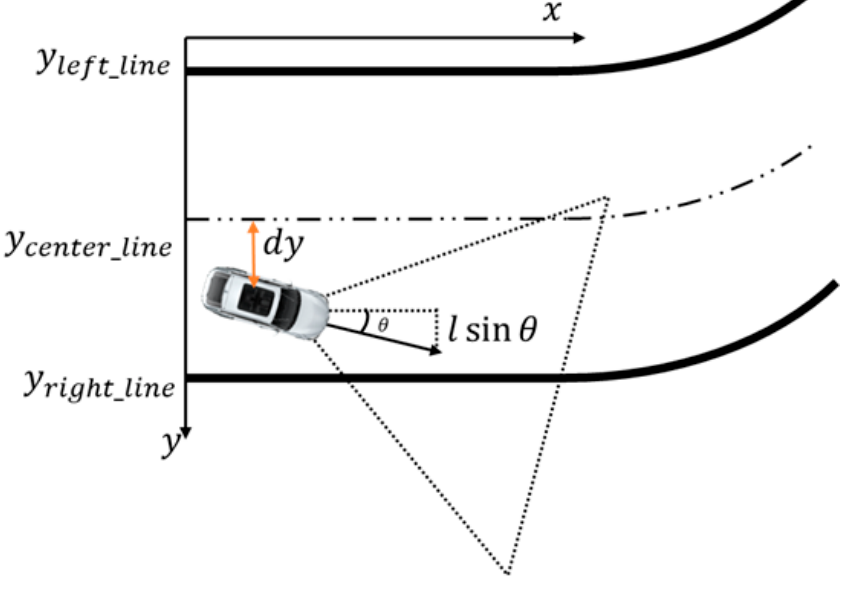
Figure 14. Steering angle calculation.